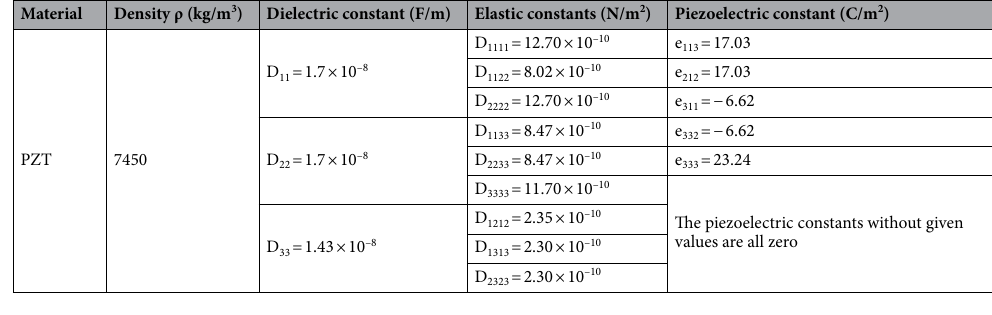
Table 2. PZT patch material parameter.